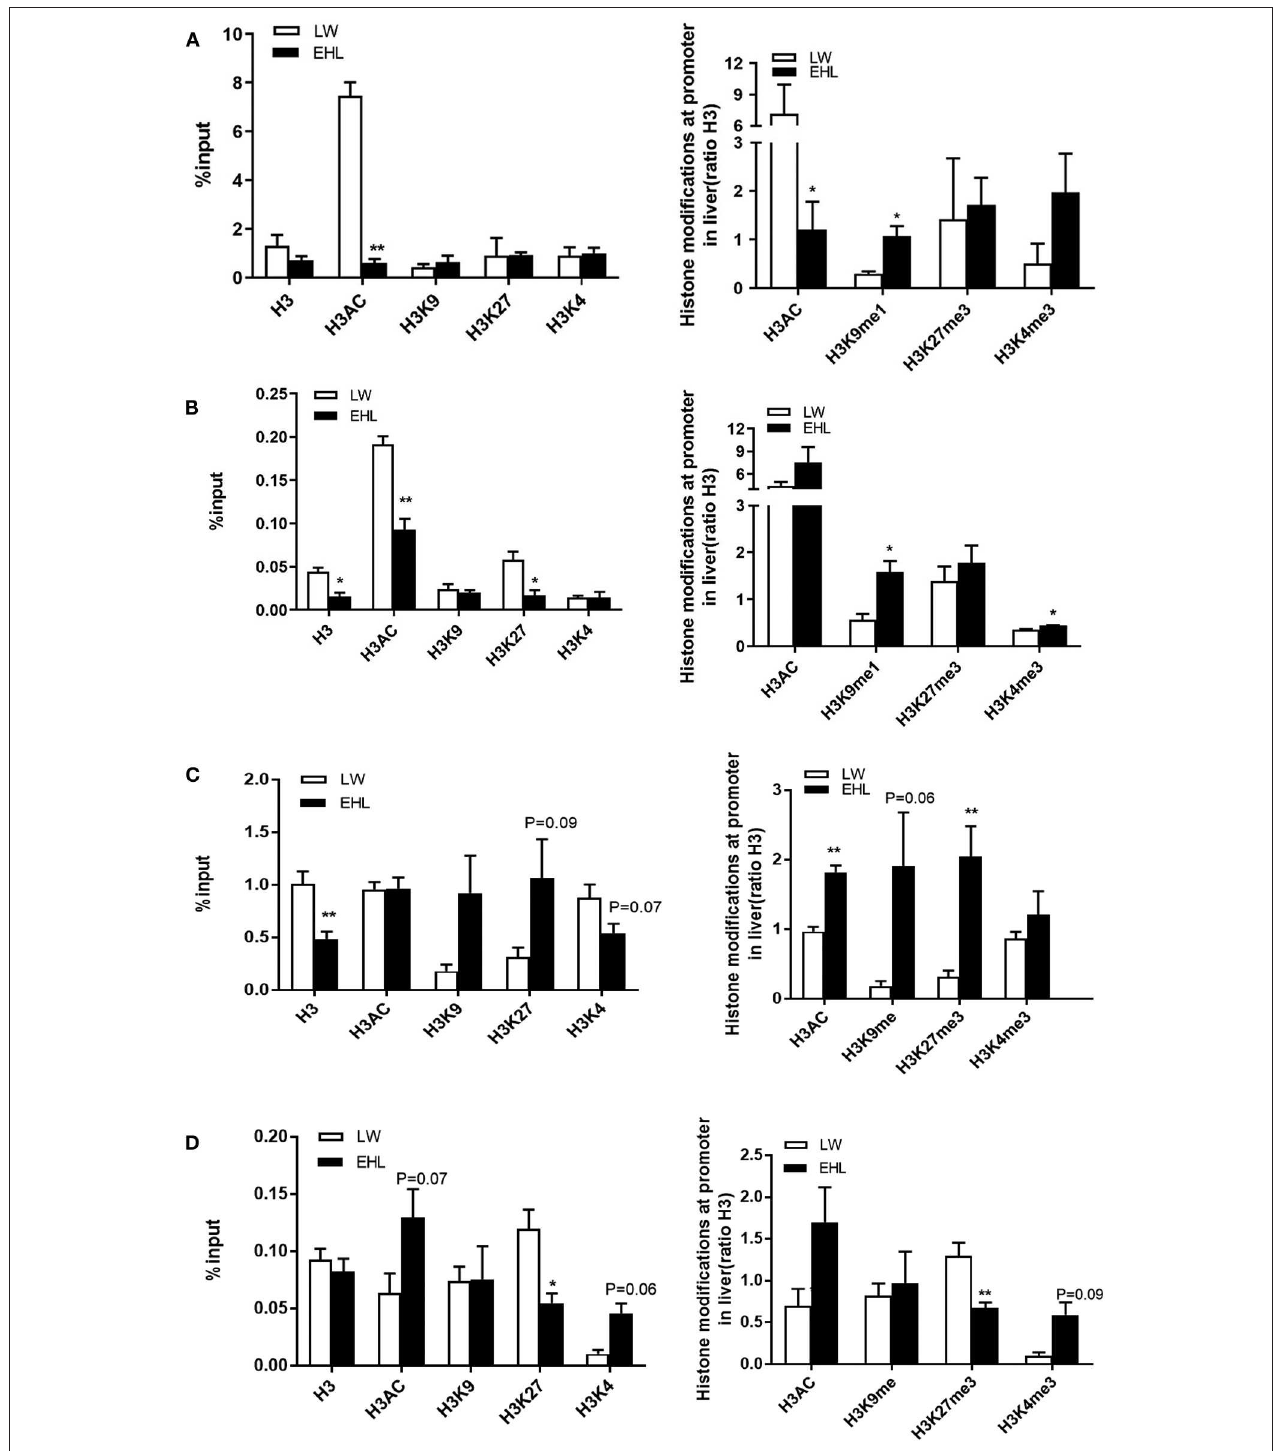
FIGURE 5 | Histone modification at HMGCR and CYP7a1 promoter in the liver of weaning piglets ( n = 6 piglets each time point per breeds). (A) Expressed HMGCR as the percentage of the input and the ratio relative to H3 at birth; (B) expressed HMGCR as the percentage of the input and the ratio relative to H3 at weaning; (C) expressed CYP7a1 as the percentage of the input and the ratio relative to H3 at birth; (D) expressed CYP7a1 as the percentage of the input and the ratio relative to H3 at weaning. * P < 0.05 and ** P < 0.01. Data are presented as mean ± SEM.